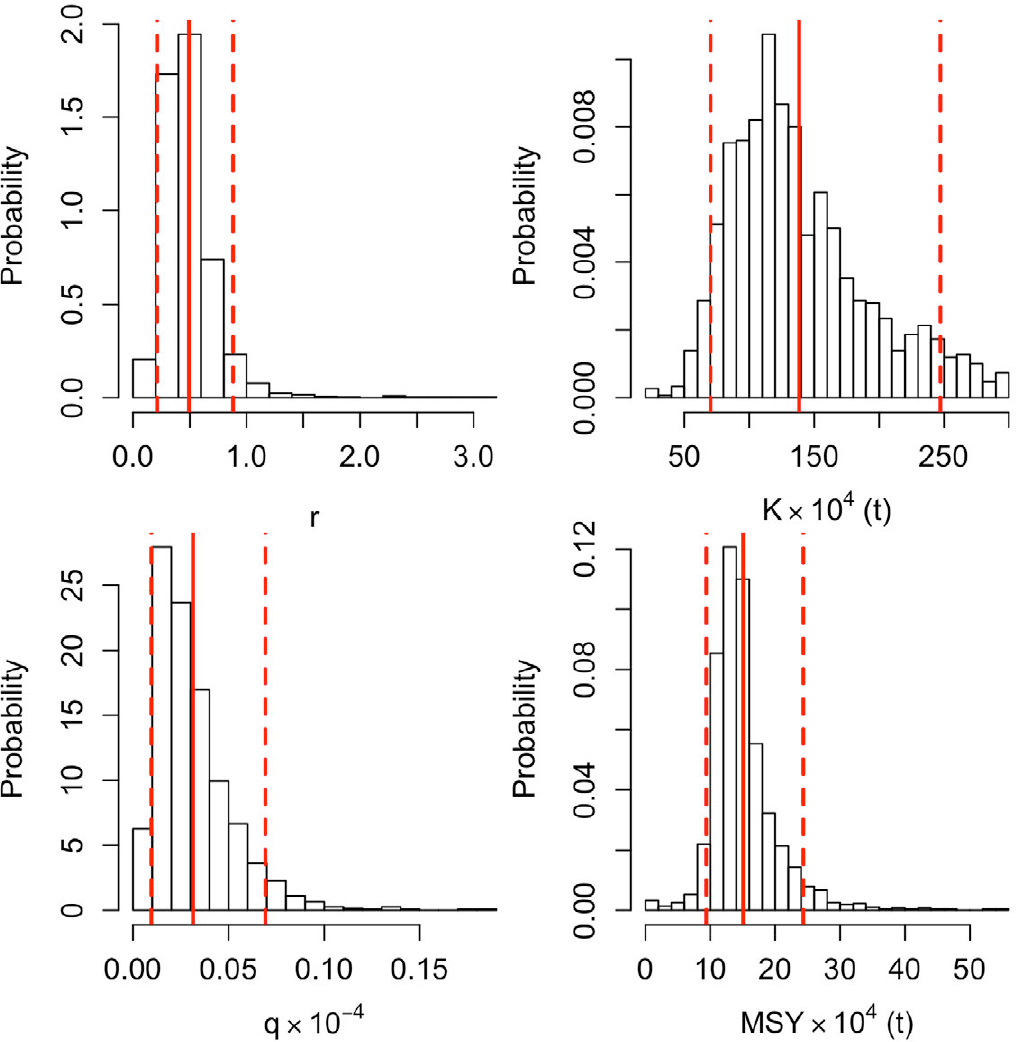
Fig. 3. – Distribution of the parameters estimated with the bootstrapped ML in the Ps-EDSP model for O. bartramii from 2003 to 2013. The red lines are the mean value for each parameter and the dotted red lines are the 95% confidence